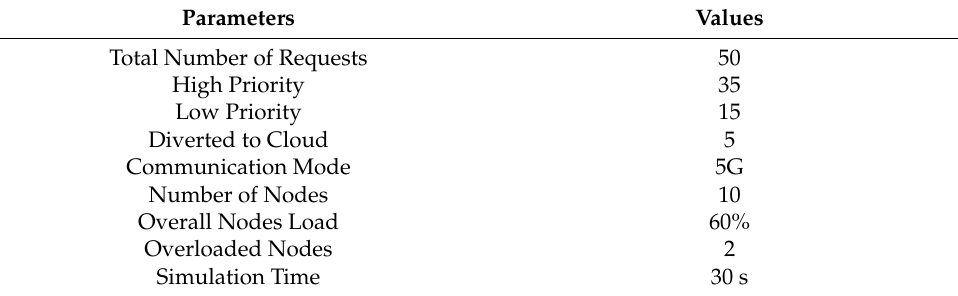
Table 2. Fog scenario 2.